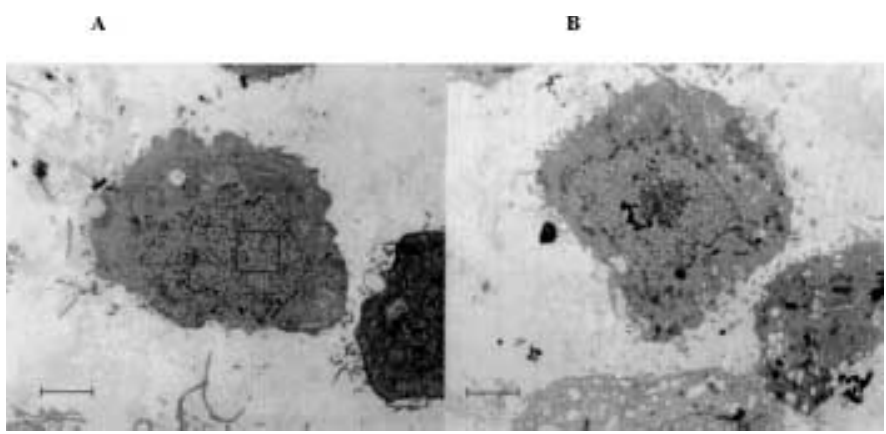
Fig. 2. EM view of SK-BR-3 cells, untreated (A) and treated with 1 µ M A23187 (B) for 24 h. (cid:1) : region of interest ROI. Magnification × 4600. Bar: 1 cm = 2.17 µ m.